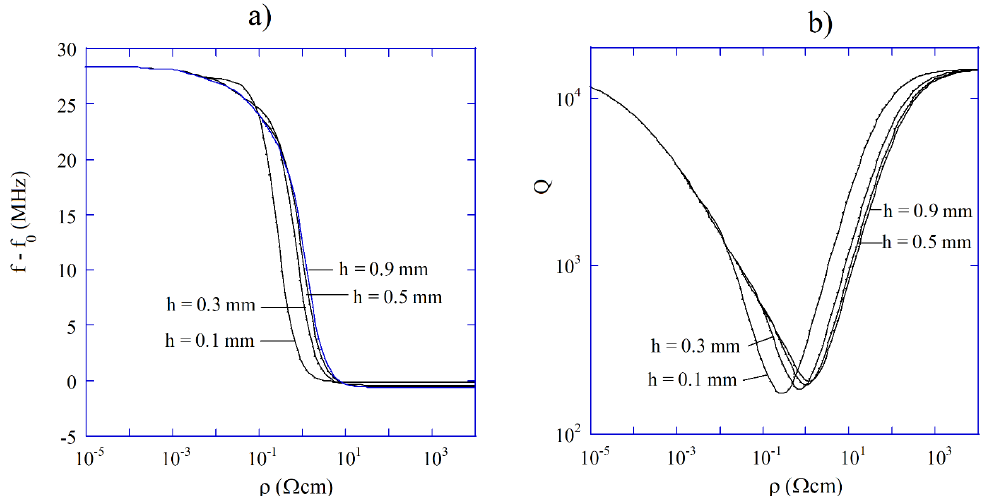
Figure 9. ( a ) Resonance frequency shift of 5 GHz single post dielectric resonator versus resistivity of semiconductor sample, ( b ) Q-factor of 5 GHz single post dielectric resonator versus resistivity of a semiconductor sample.